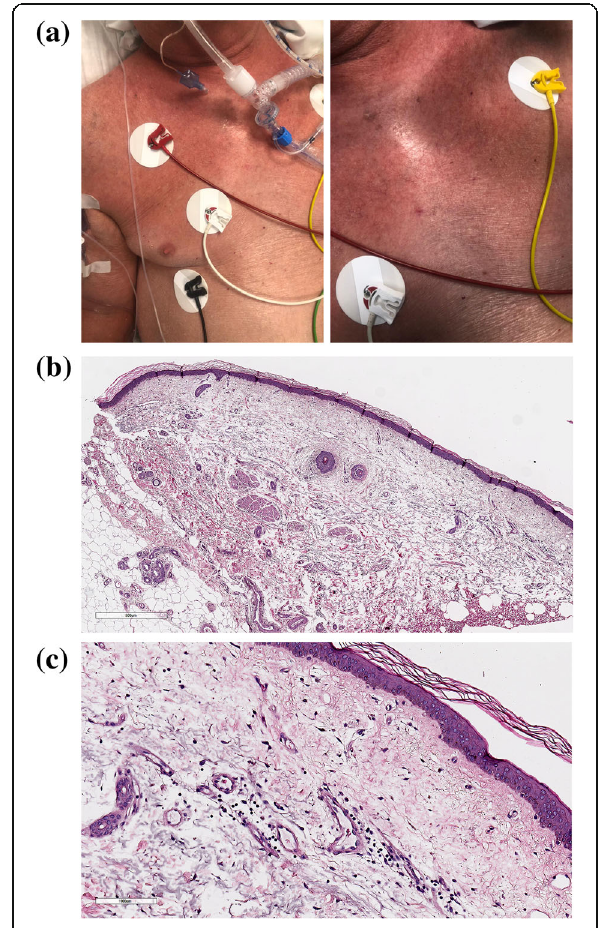
Fig. 2 a Sub-erythroderma with mild exfoliation, affecting trunk, upper limbs, neck and face; b , c Edema and moderate chronic lymphocytic inflammation, mainly perivascular, were present in the papillary and superficial reticular dermis (A:H&E, 5x; B:H&E,